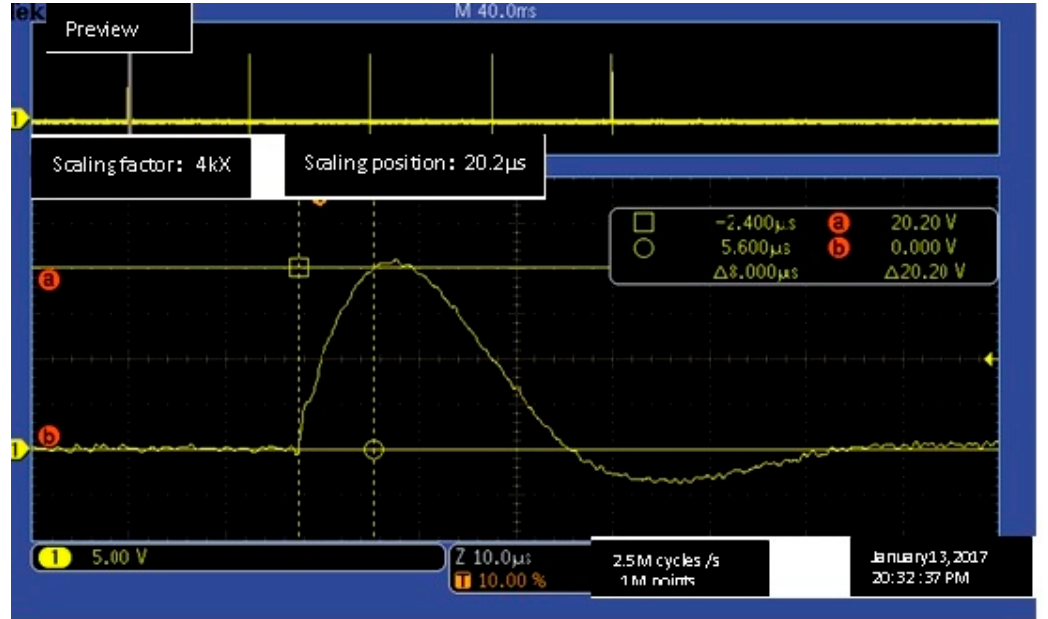
Figure 3. Five-pulse lightning waveform diagram.